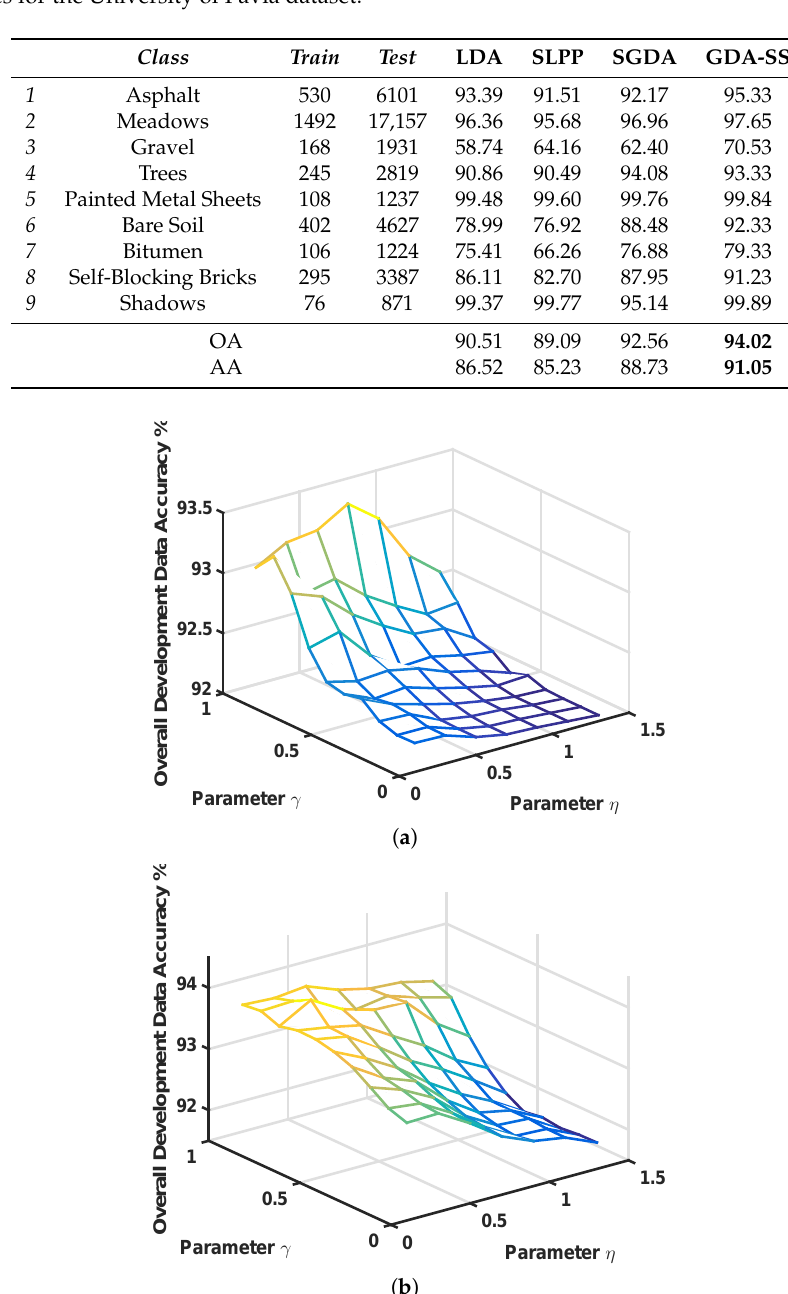
Table 2. SVM class-specific accuracy (%), overall accuracy (OA) and average accuracy (AA) of different techniques for the University of Pavia dataset.